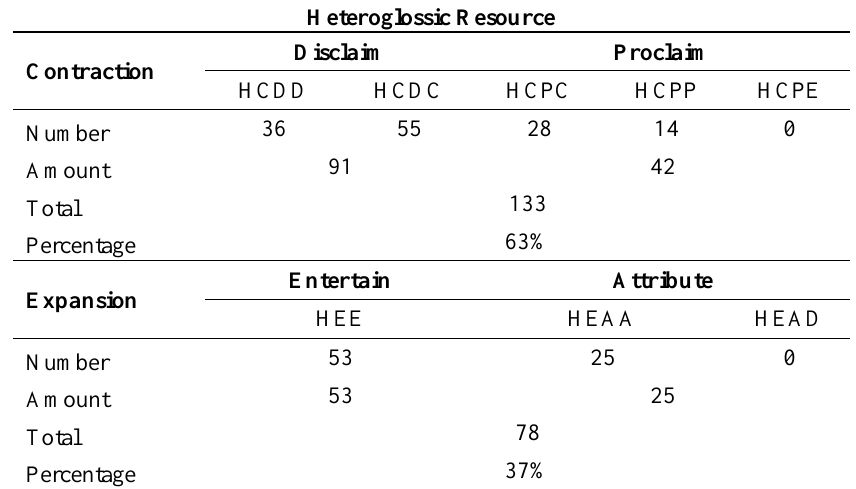
Table 7. Table of frequency of heteroglossic resources